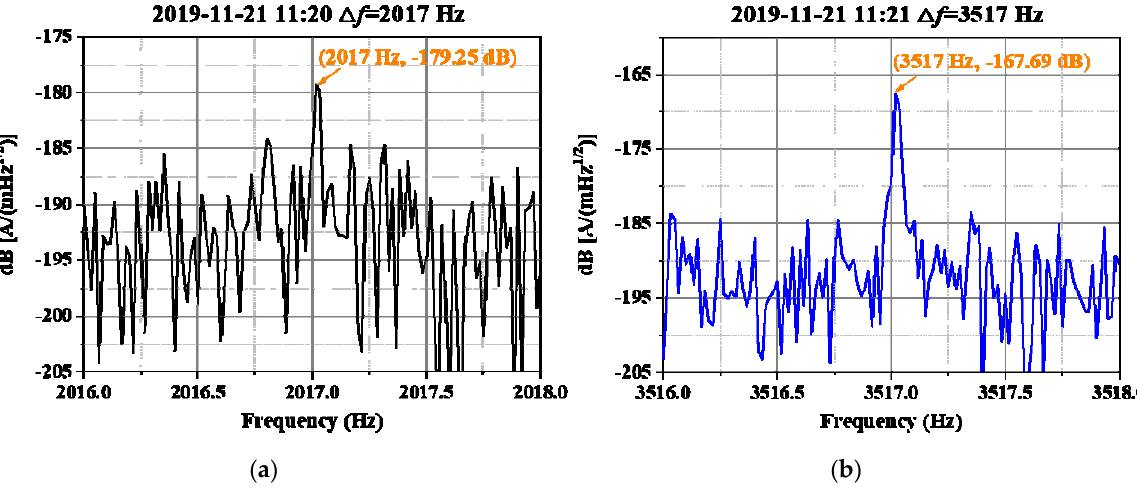
Figure 5. Amplitudes of the north–south magnetic field generated by the BW X-mode modulation heating for ( a ) 2017 Hz and ( b ) 3517 Hz.